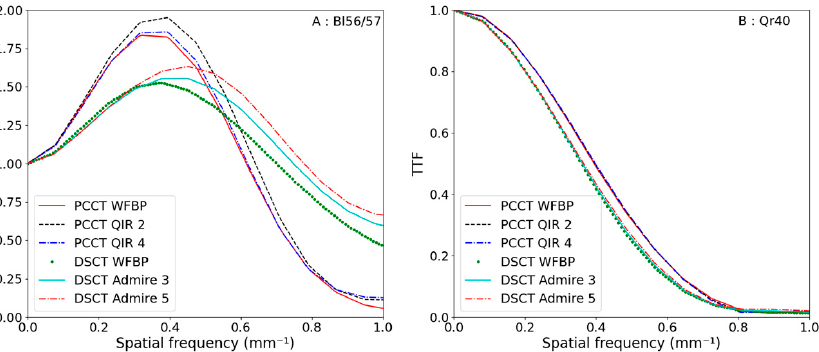
Figure 6. TTF Air obtained on both CTs for polyenergetic and virtual monoenergetic acquisitions for 3 reconstruction strength levels at 10 mGy. Table 5. F 50% (mm − 1 ) of PCCT and DSCT for polyenergetic acquisitions for all reconstruction strength levels and for the three CTDI vol (1, 5, 10 mGy).